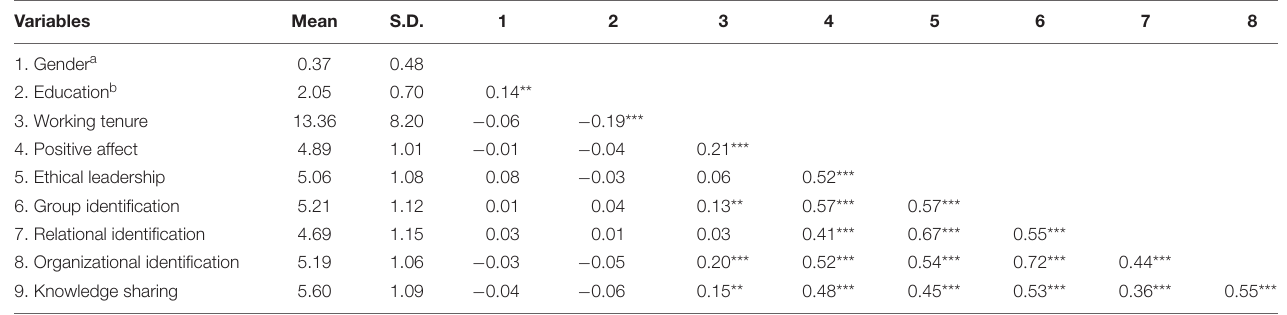
TABLE 1 | Means, standard deviations, and correlations. Variables